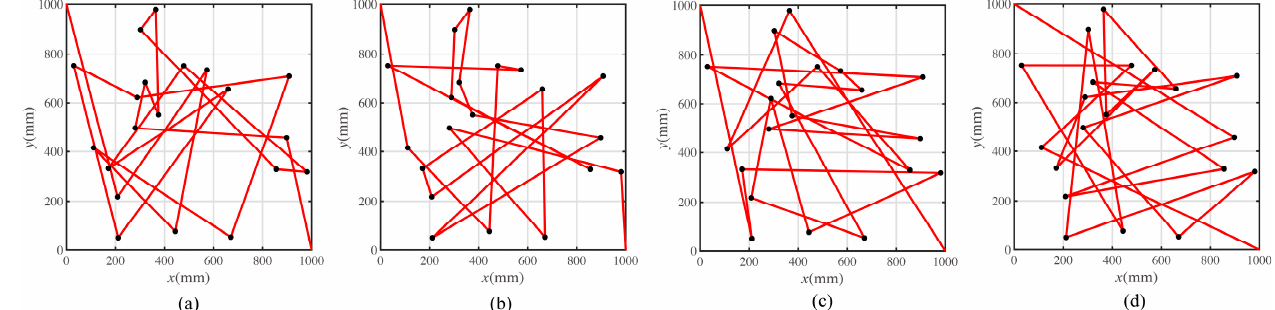
Figure A1. Random generated paths for parameter recognition. ( a ) The first random moving path. ( b ) The second random moving path. ( c ) The third random moving path. ( d ) The fourth random moving path. In Figure A1, the points in black represent the target positions. The lines in red represent the moving path for mobile robot. The correspondence data between the expected movement distances and actual movement distances are shown in Table A2. The correspondence data between the expected rotation angles and actual rotation angles are shown in Table A3. The fitted radius data of the forward-moving trajectory are shown in Table A4. Only the trajectories whose captured pulse lengths were larger than 1500 were used for fitting the trajectory radius.